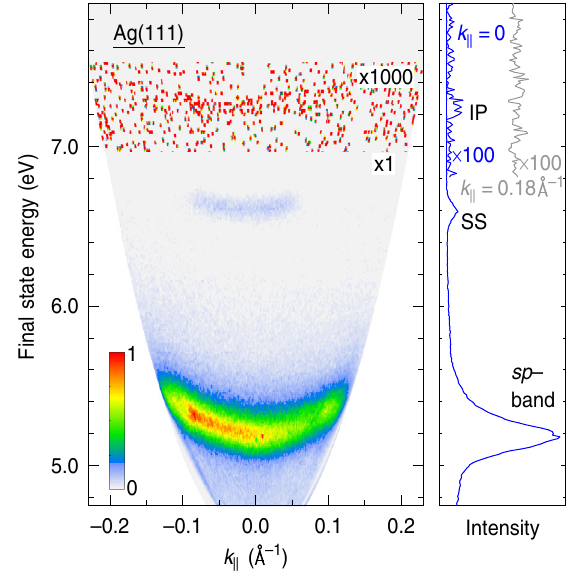
FIG. 2. Energy- and k k -resolved 2PP spectra of Ag(111) [ ℏ ω l ¼ 3 . 32 eV; the corresponding excitation diagram for the SS state is given in Fig. 1(a)]; the photoemission spectral elements are labeled in the line profile (right, blue) taken at k ¼ 0 . The SS state and the sp band are detected through k coherent two-photon excitation and resonant two-photon absorp- tion from L sp to U sp , respectively. The color intensity scale represents the photoelectron counts; above 7 eV, the color scale is amplified by a factor of 1000 to show the weak contribution of the first IP state. The pixelated image results from photoelectron- counting statistics. As emphasized by the line profiles shown for k ¼ 0 Å − 1 (blue) and k ¼ 0 . 18 Å − 1 (gray), the IP state is k k detected only for the k k range in which the SS state is occupied, demonstrating that it is excited by a nonresonant one-photon absorption from